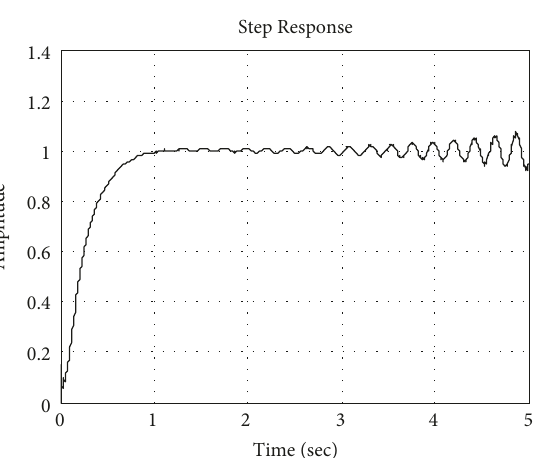
Figure 22: Response curve at 0.1 times β